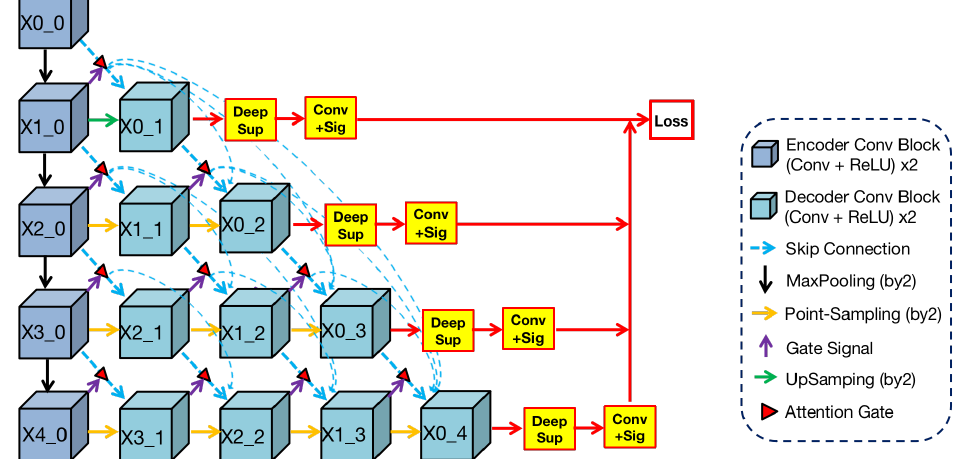
Figure 3. Structure of Render 3D U-Net: All convolutional blocks extract semantic information by convolution layers and ReLU activation functions. From a horizontal perspective, each block in the decoder point-samples features are from its preceding block. From a vertical perspective, each block in the encoder transfers features from top to bottom through the maxpooling layer, and each block in the decoders concatenates multi-resolution features from all preceding blocks through dense skip